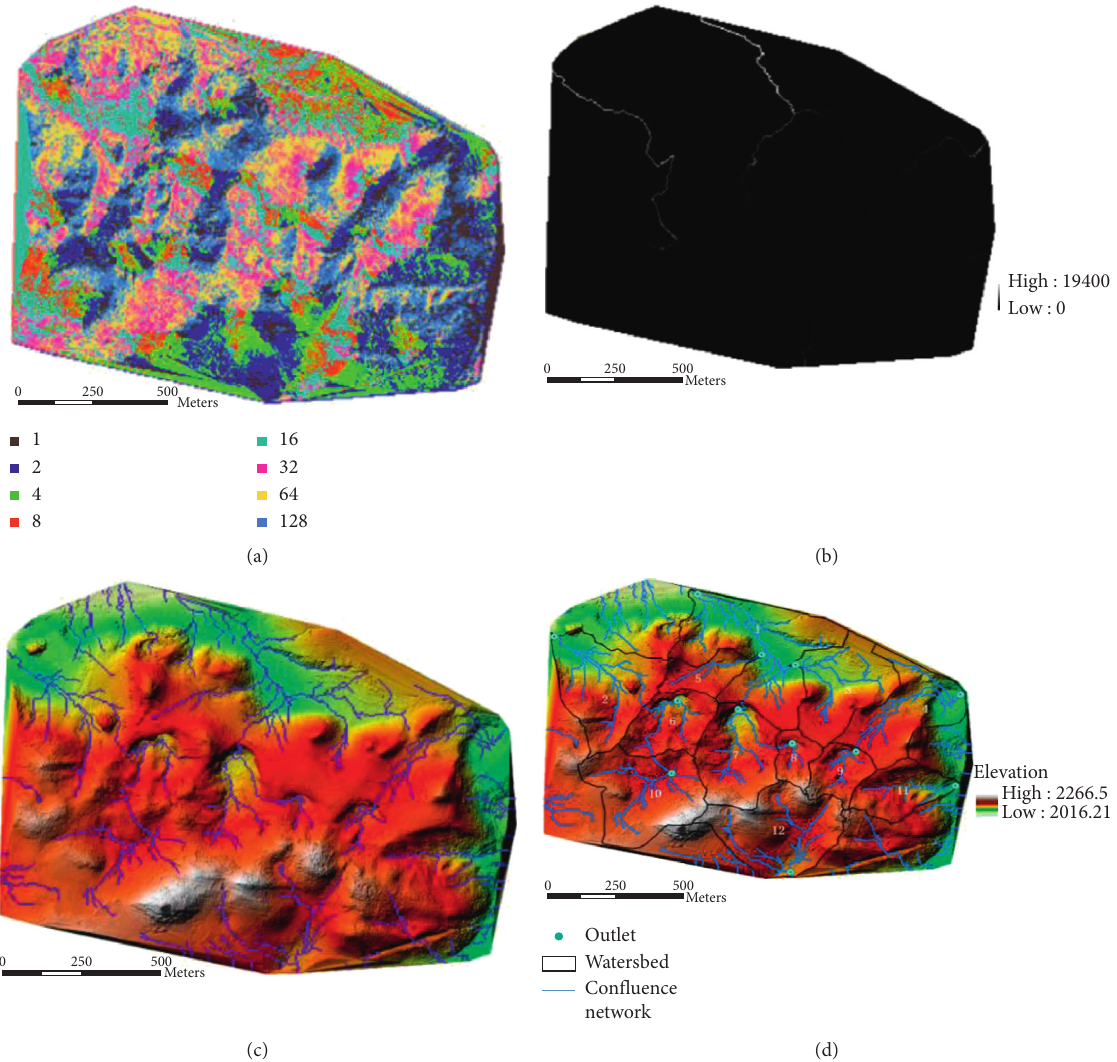
Figure 6: Catchment analysis and watershed division: (a) value of flow direction; (b) confluence flow; (c) confluence river networks; (d) watershed